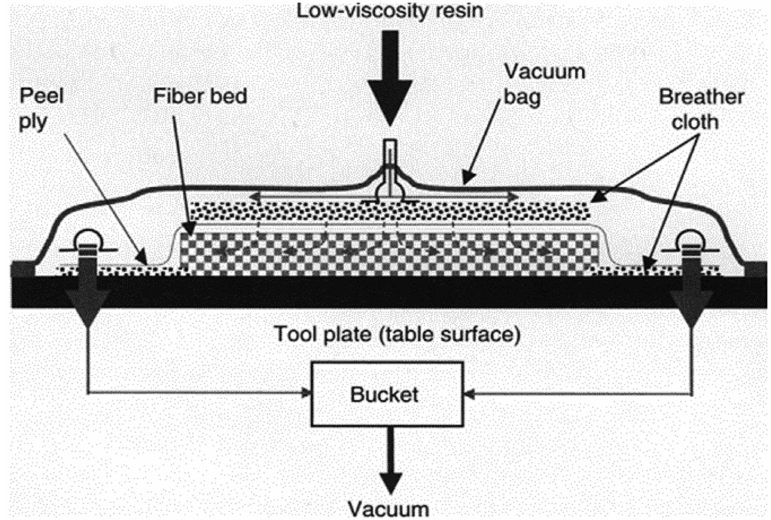
Figure 8. Schematics of VARTM [71]. Reprinted with permission from